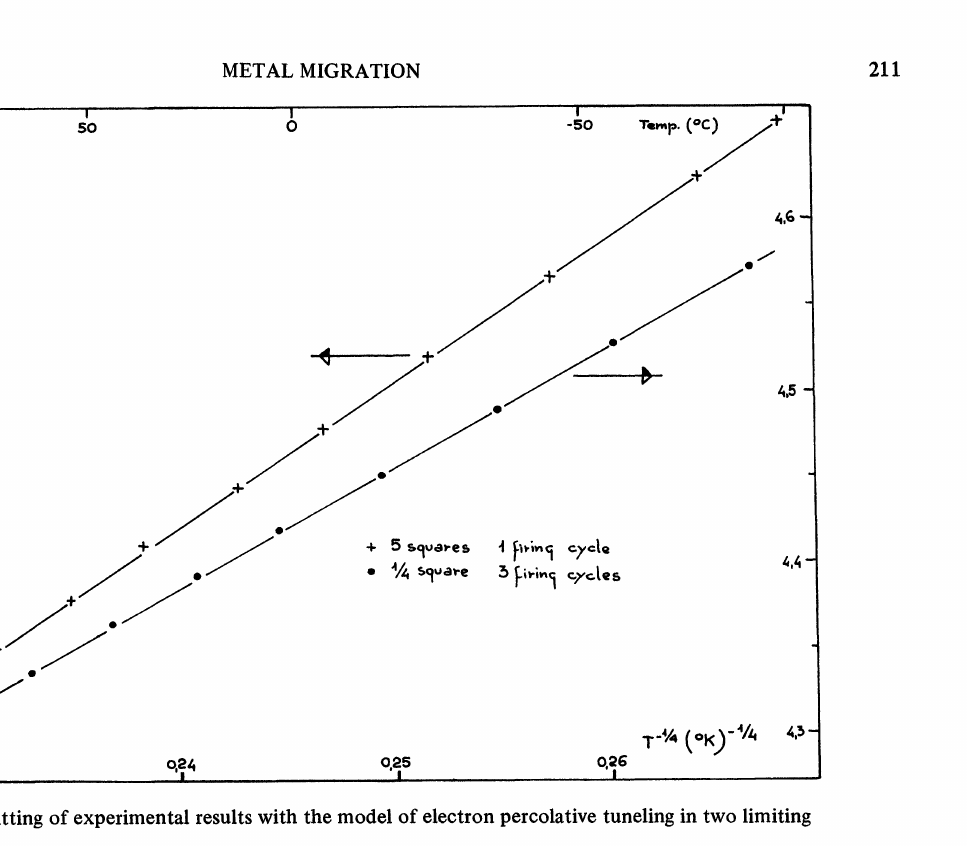
FIGURE 10 Fitting of experimental results with the model of electron percolative tuneling in two limiting situations. concentration of metal migrates in this case (lower than the EMPA detectivity of